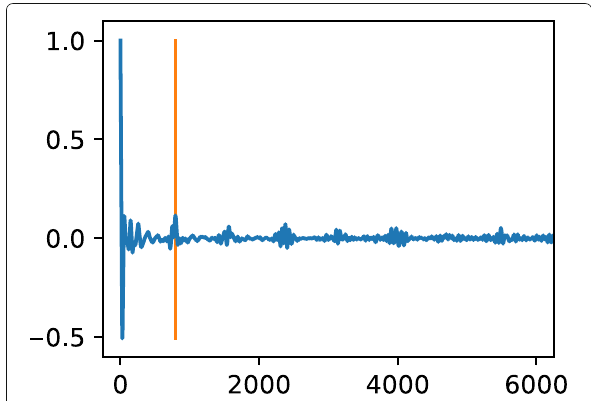
Fig. 12 Autocorrelation function of one of the ECG database records are computed. Here M denotes the total number of sub-